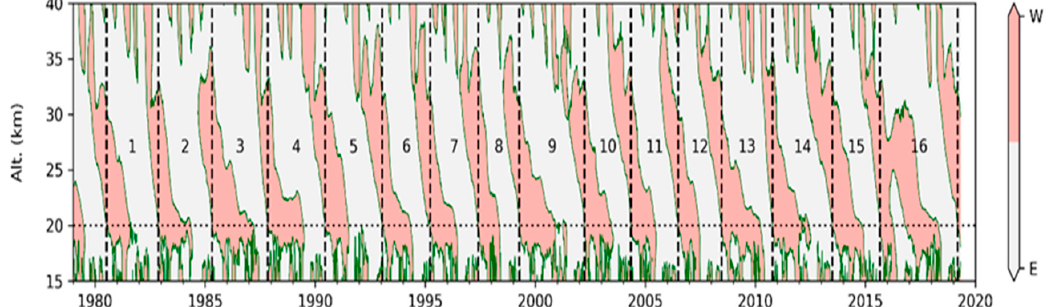
Figure 1. The phase of the daily ERA-Interim zonal mean zonal wind over the equatorial (±10°) region during the study period of 1979–2019. The mark “W” stands for westerly and “E” stands for easterly. The dotted line indicates a 20 km altitude, and the dashed lines divide different quasi-biennial oscillation (QBO) cycles, where each cycle starts and ends when the corresponding westerly shear descends to a 20 km altitude. The identification number of each QBO cycle is also presented.